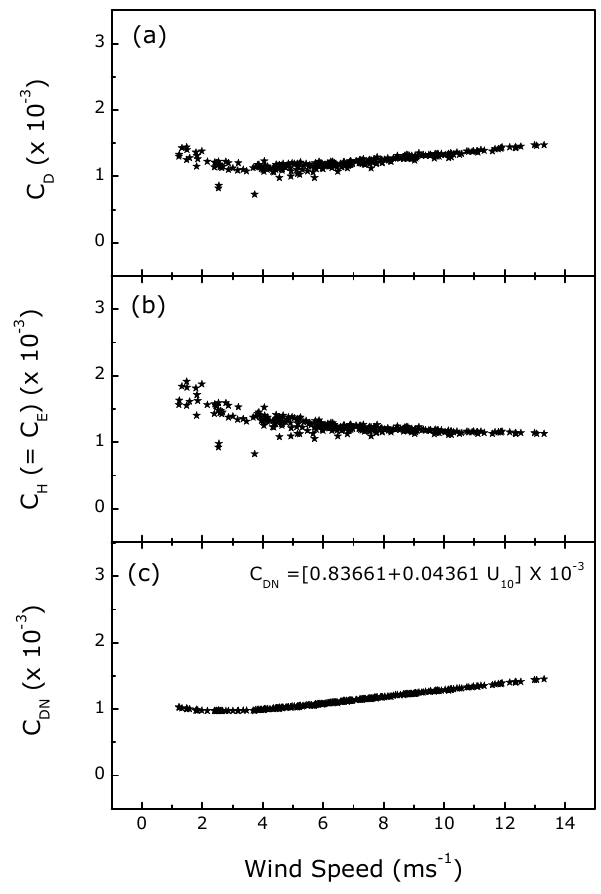
Fig. 8. Wind speed dependence of air-sea exchange coefficients: (a) C H (= C E ); (b) C D and (c) C DN